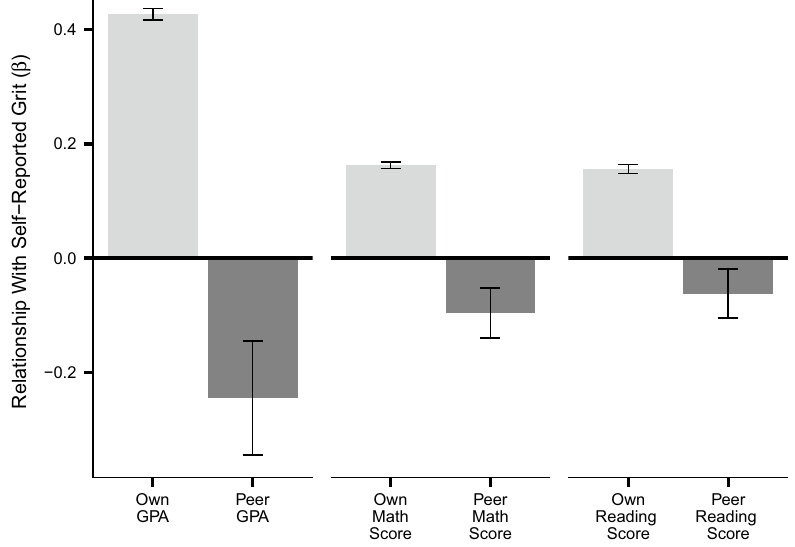
Figure 2. In Study 1, self-reported grit correlated positively with a student’s own academic performance but inversely with the performance of their schoolmates. OLS models included demographic controls and school fixed effects. Error bars represent 95% confidence intervals. Model R 2 s for GPA, math score, and language score were 0.124, 0.071, and 0.071,